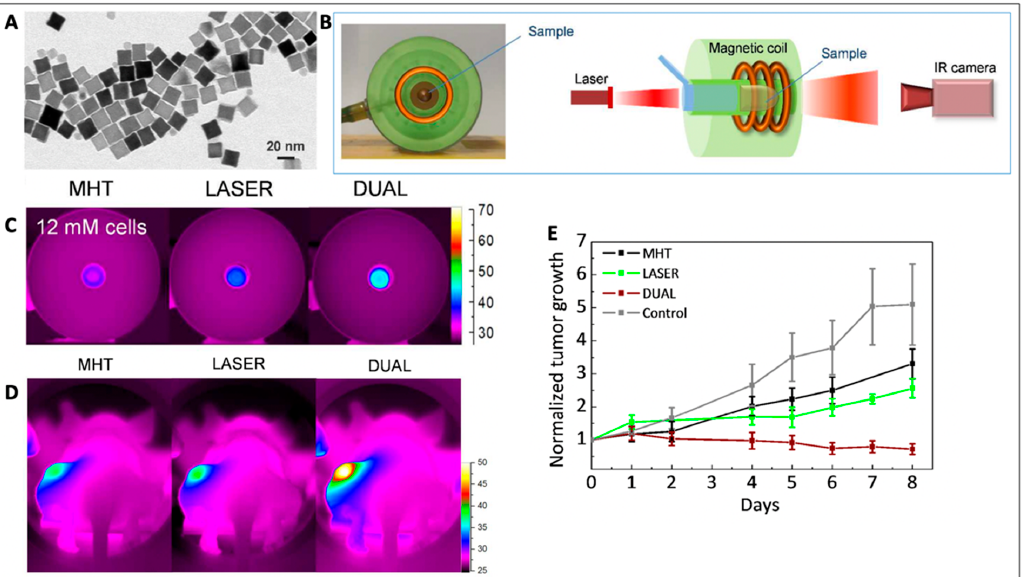
Figure 5. ( A ) TEM image of iron oxide nanocubes. ( B ) Schematic illustration of experimental device consisting of a magnetic coil and 808 nm laser for combined magnetic hyperthermia and photothermal therapy. ( C ) Thermal images acquired of cells by infrared camera after in vitro treatment. ( D ) Thermal images of mouse (in vivo study) acquired by infrared camera after treatment. ( E ) Tumor growth curve for a period of 8 days. Reproduced with permission from Ref. [116]. Copyright 2016 American Chemical Society.